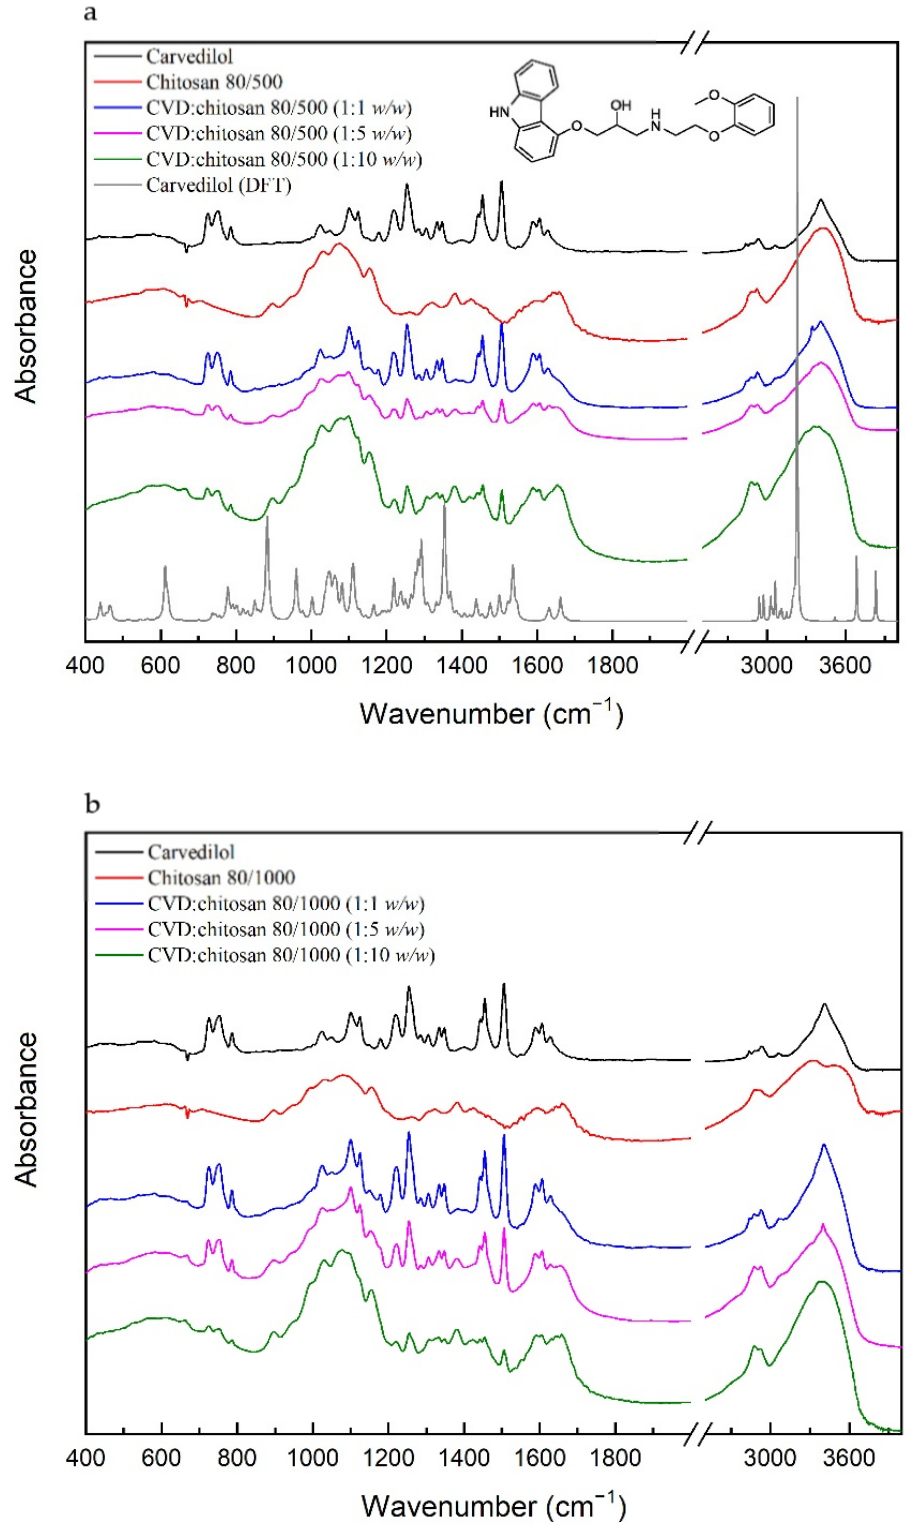
Figure 2. The IR absorption spectra of the solid systems of CVD-chitosan 80/500 ( a ) and CVD-chitosan 80/1000 at room temperature ( b ).